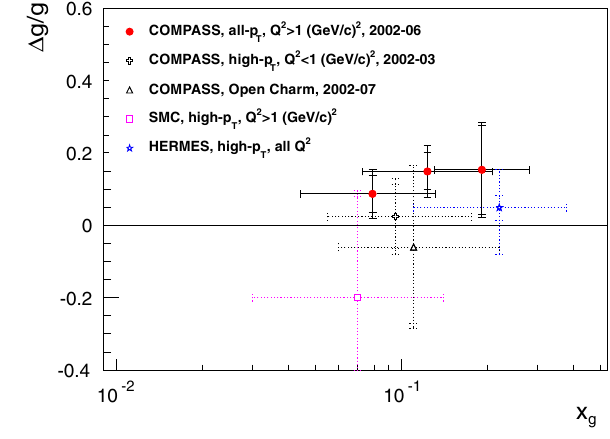
and the outer ones the statistical and systematic uncertainties combined in quadrature. The horizontal error bars represent the x g interval in which 68% of the MC events are